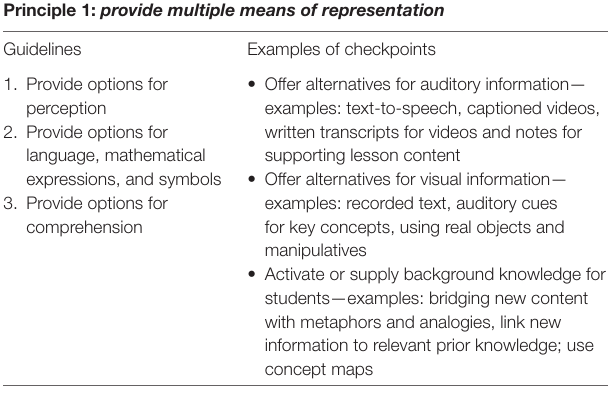
tABLe 1 | The Universal Design for Learning principles, guidelines, and checkpoint